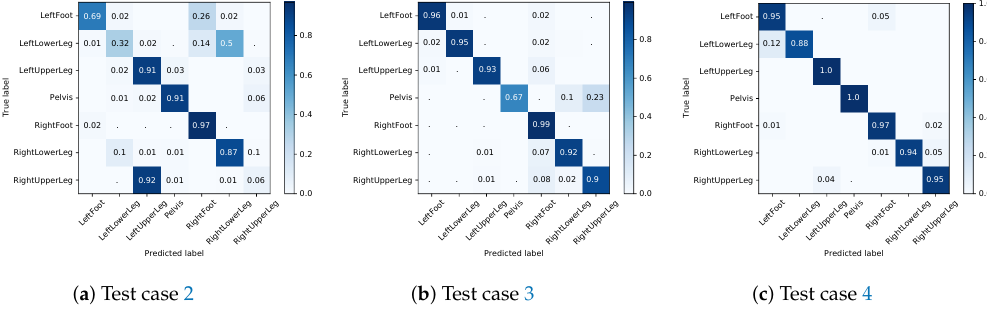
Figure 12. Evaluation results in terms of confusion matrices for the I2S assignment problem on dataset B .